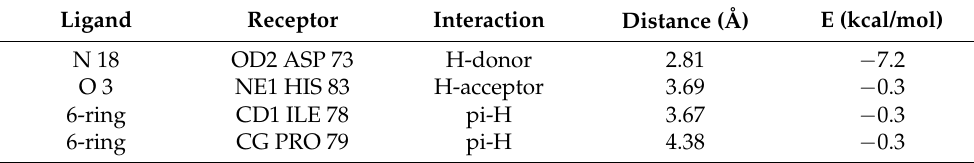
Table 3. Binding interactions of DNSPA with the amino acid residues of 5MMN.